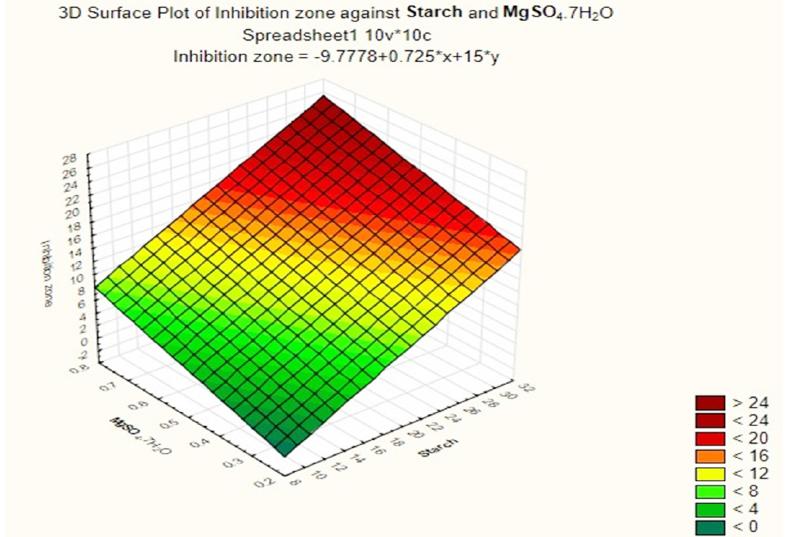
with respect to inhibition zone diameter of antimicrobial 4